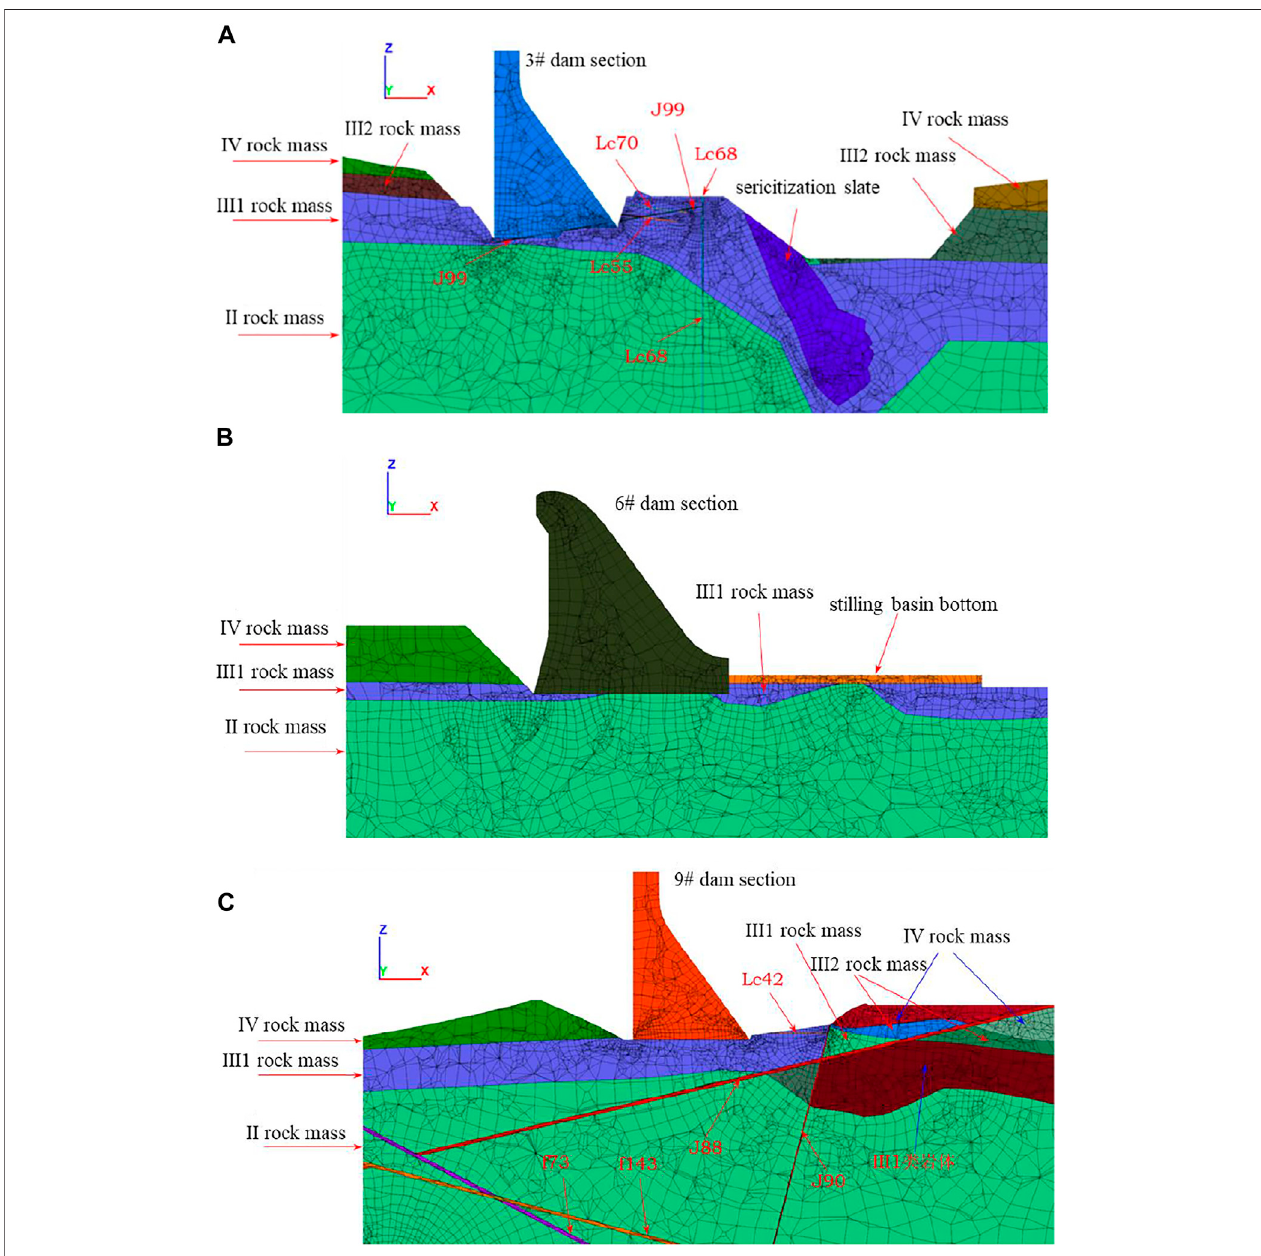
FIGURE 7 | The pro fi les cutting through the centers of the (A) dam section 3, (B) dam section 6, and (C) dam section 9.